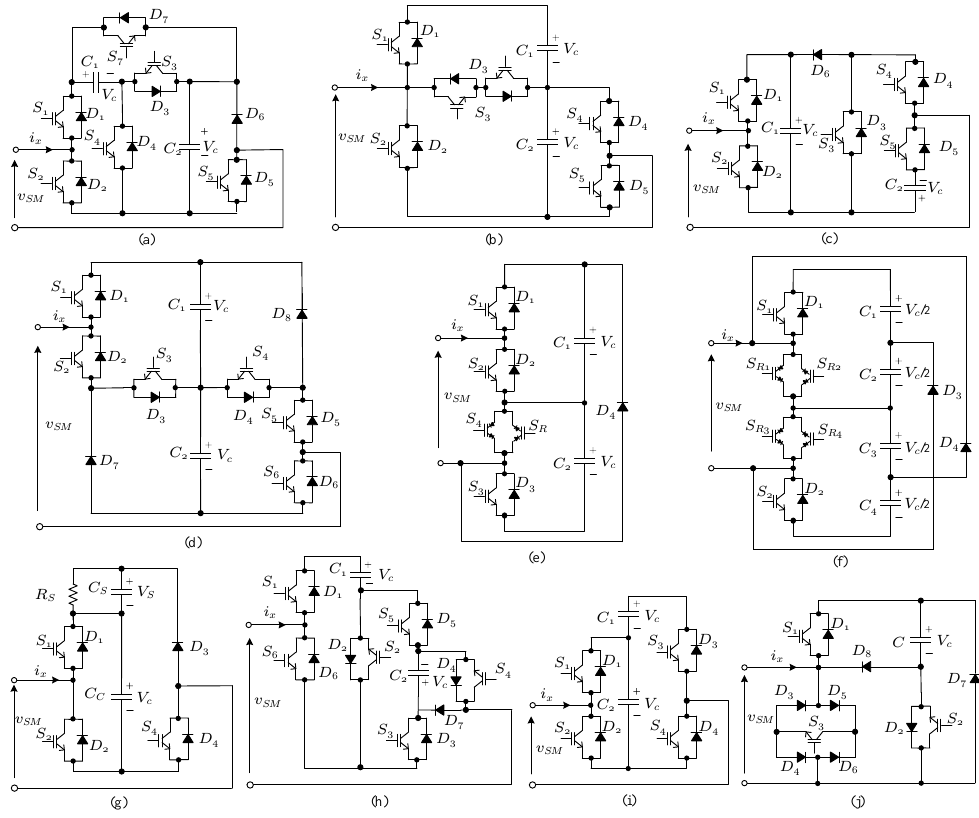
Figure 6. Bipolar SMs (cntd.): ( a ) CSM—Self-blocking composite multilevel SM; ( b ) 4LT 2 C— 4- Level T-Type Neutral Point-Clamped SM; ( c ) T 2 HBSM—T-type half-bridge based SM; ( d ) ACTSM— Active clamped T-type SM; ( e ) HDDBSM—Hybrid Double Direction Blocking SM; ( f ) M-HDDBSM— Modified Hybrid Double Direction Blocking SM; ( g ) AUFBSM—Asymmetrical unipolar full-bridge SM; ( h ) SwCSM—Switched-capacitor SM; ( i ) ASM—Asymmetrical SM; and ( j ) DCBSSM—Diode clamp with bidirectional switch